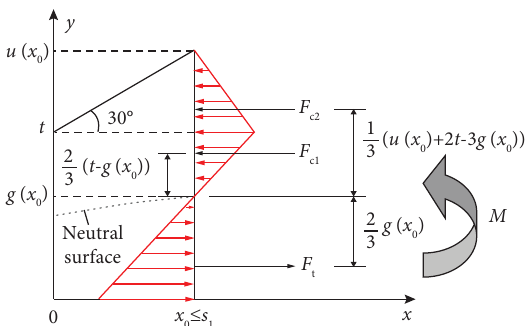
Figure 2: Te stress distribution on the cross section at x � x range from x � 0 to x � s